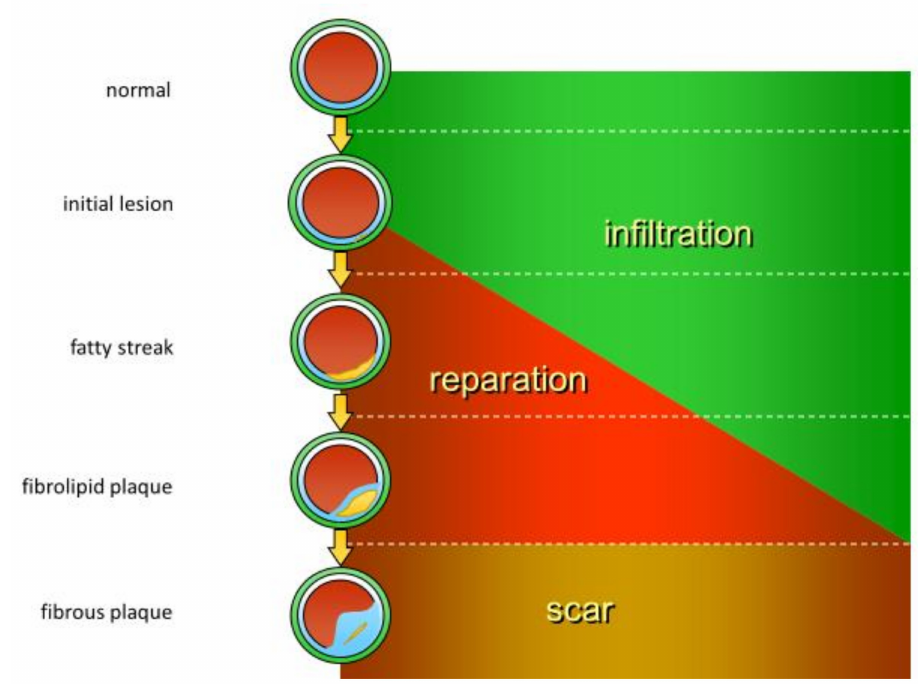
Figure 1. Phases of inflammation in relation to atherosclerotic lesion development. The commonly accepted course of atherosclerotic lesion progression generally corresponds to the consecutive stages of theinflammatoryresponse, withtheformationofstable,